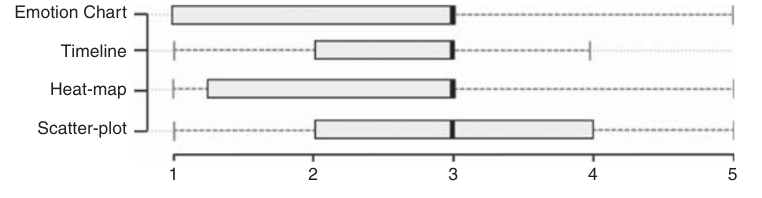
Figure 7. Usefulness marks from 1 to 5 for each